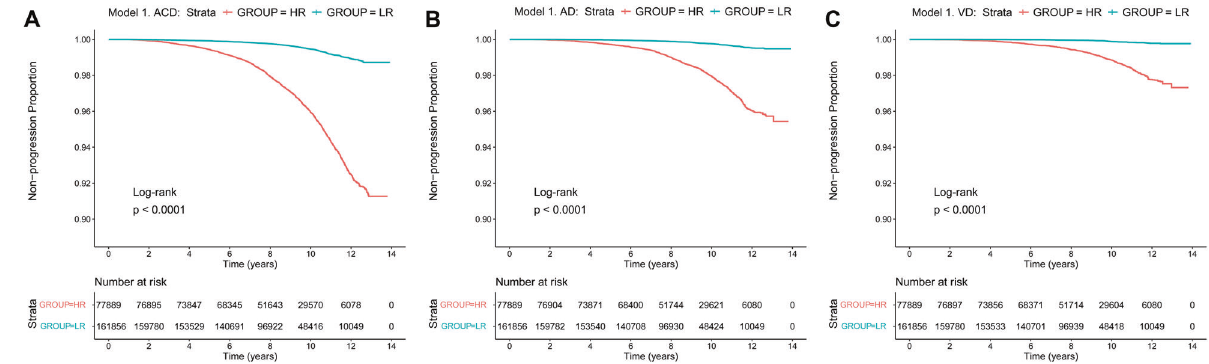
Fig. 3 Kaplan – Meier survival curves predict ACD, AD, and VD risk in the basis of model 1. Patients in the HR group had faster clinical progression ( p logrank < 0.0001) compared with those in the LR group in model 1 for ACD ( A ), AD ( B ), and VD ( C ). ACD all-caused dementia, AD Alzheimer ’ s disease, VD vascular dementia, LR low risk, HR high risk.